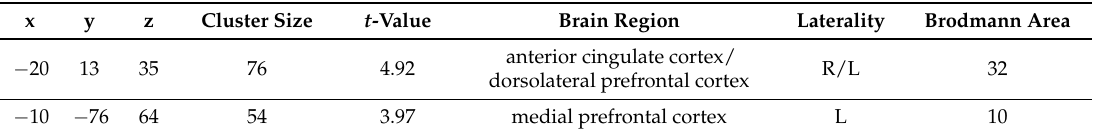
Table 2. Activations to pain-related versus negative words in the comparison between CBP patients and HC.